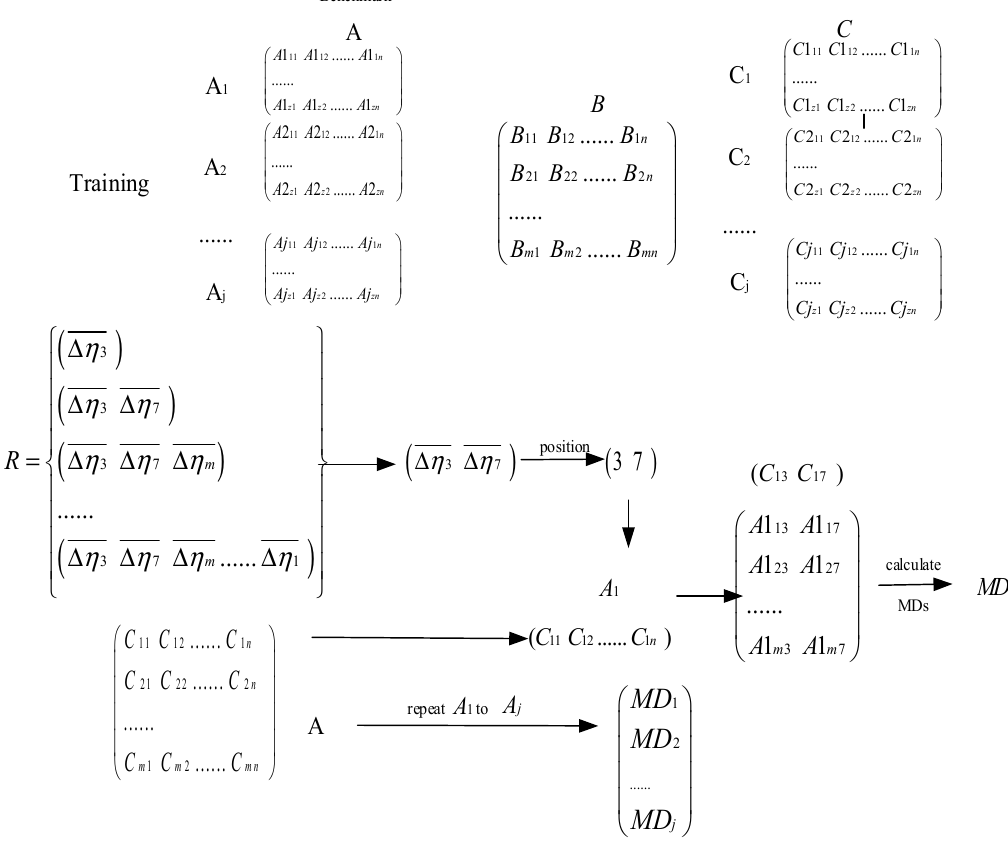
Figure 5. The third step of aMMTS.